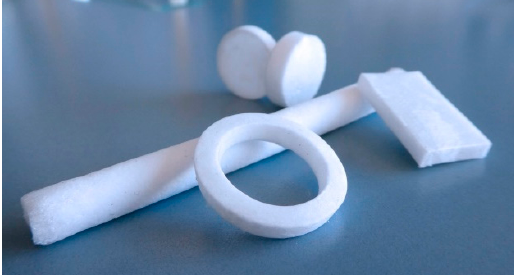
Figure 5. Different geometries of prepared cryogels.